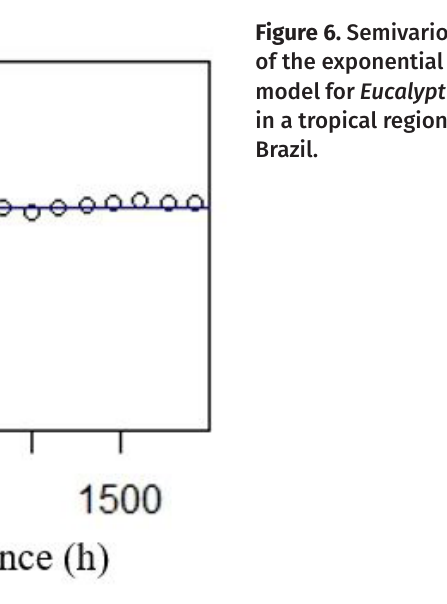
Table V. Cross-validation results for the exponential model for Eucalyptus sp. in a tropical region of Brazil. Angular Linear Number of Model coefficient neighbors coefficient Exponential 2.8753